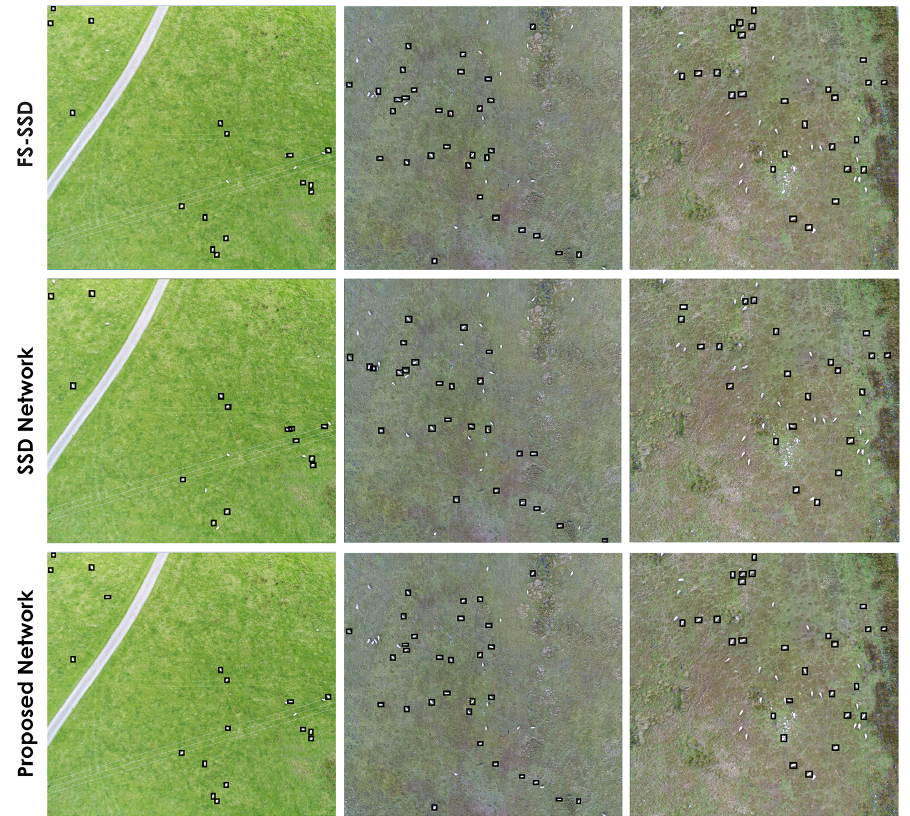
Figure 10. Comparison of small object detection between the proposed network ( bottom row ), the SSD network ( middle row ) and the FS-SSD network ( top row ) on the custom livestock dataset. Furthermore, a qualitative evaluation of the proposed model detection performance is shown in Figure 11. The ground truth and the predicted bounding boxes are shown in blue and red, respectively. It can be observed that the prediction bounding boxes are reasonably aligned with the ground truth and the object in the image.